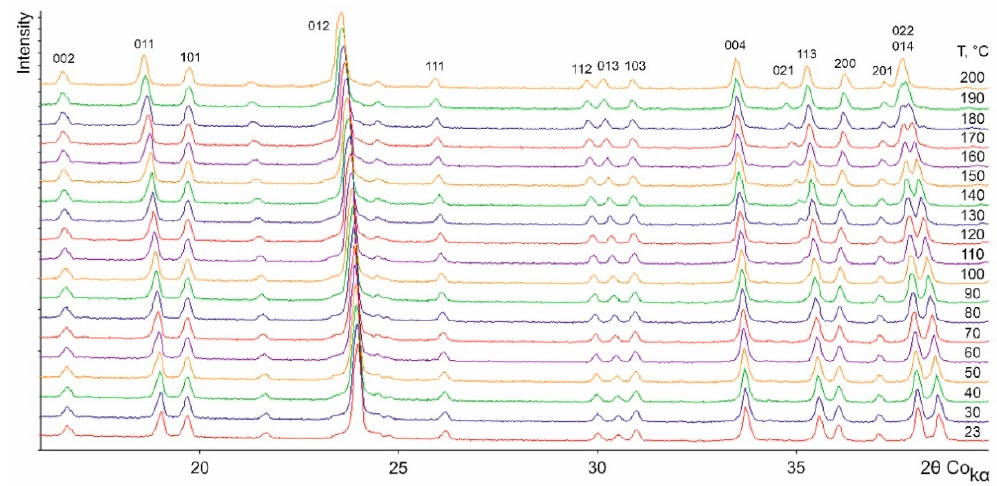
Figure 5. X-ray patterns (2 θ Co K α ) of an L-ala sample obtained at various temperatures.